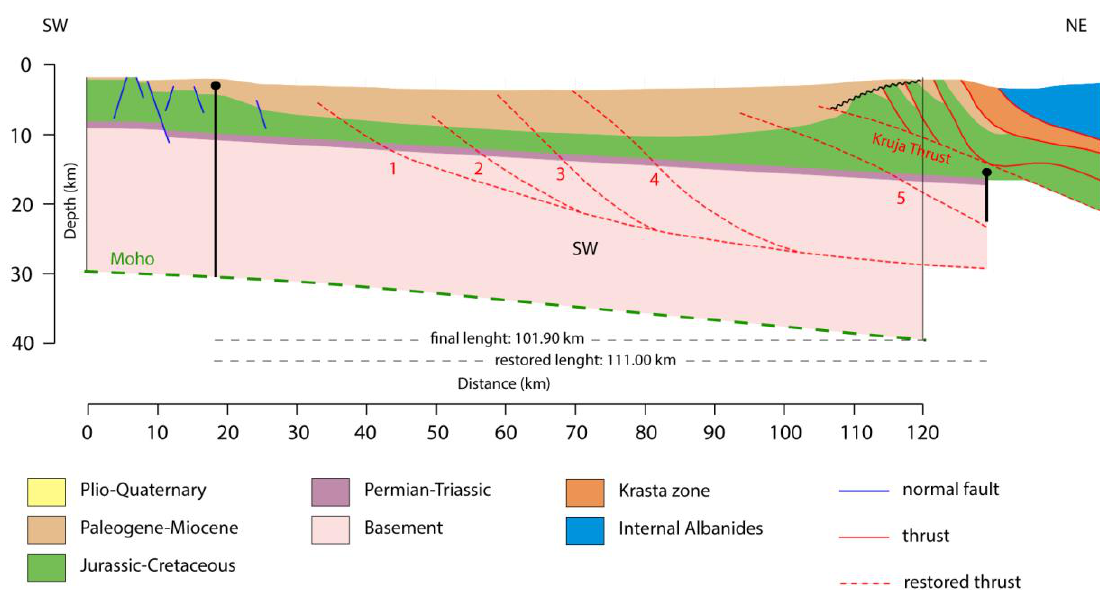
Figure 5. Restored regional geological section of Figure 4. The Kruja, Krasta and inner Albanides units were not restored, as they are not relevant for the present study.